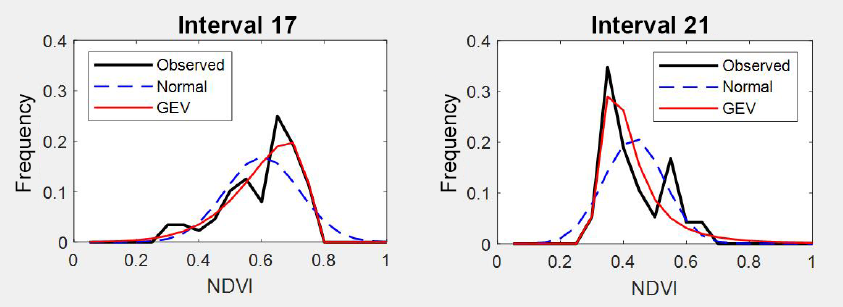
Figure 6. Comparison between observed NDVI frequency, GEV and normal probability density functions on two different dates. Intervals 17 and 21 are examples for